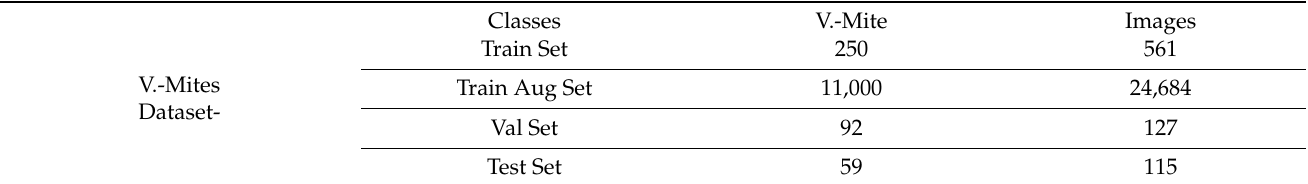
Table 4. The table shows the number of annotated objects of given classes of the Varroosis only dataset.